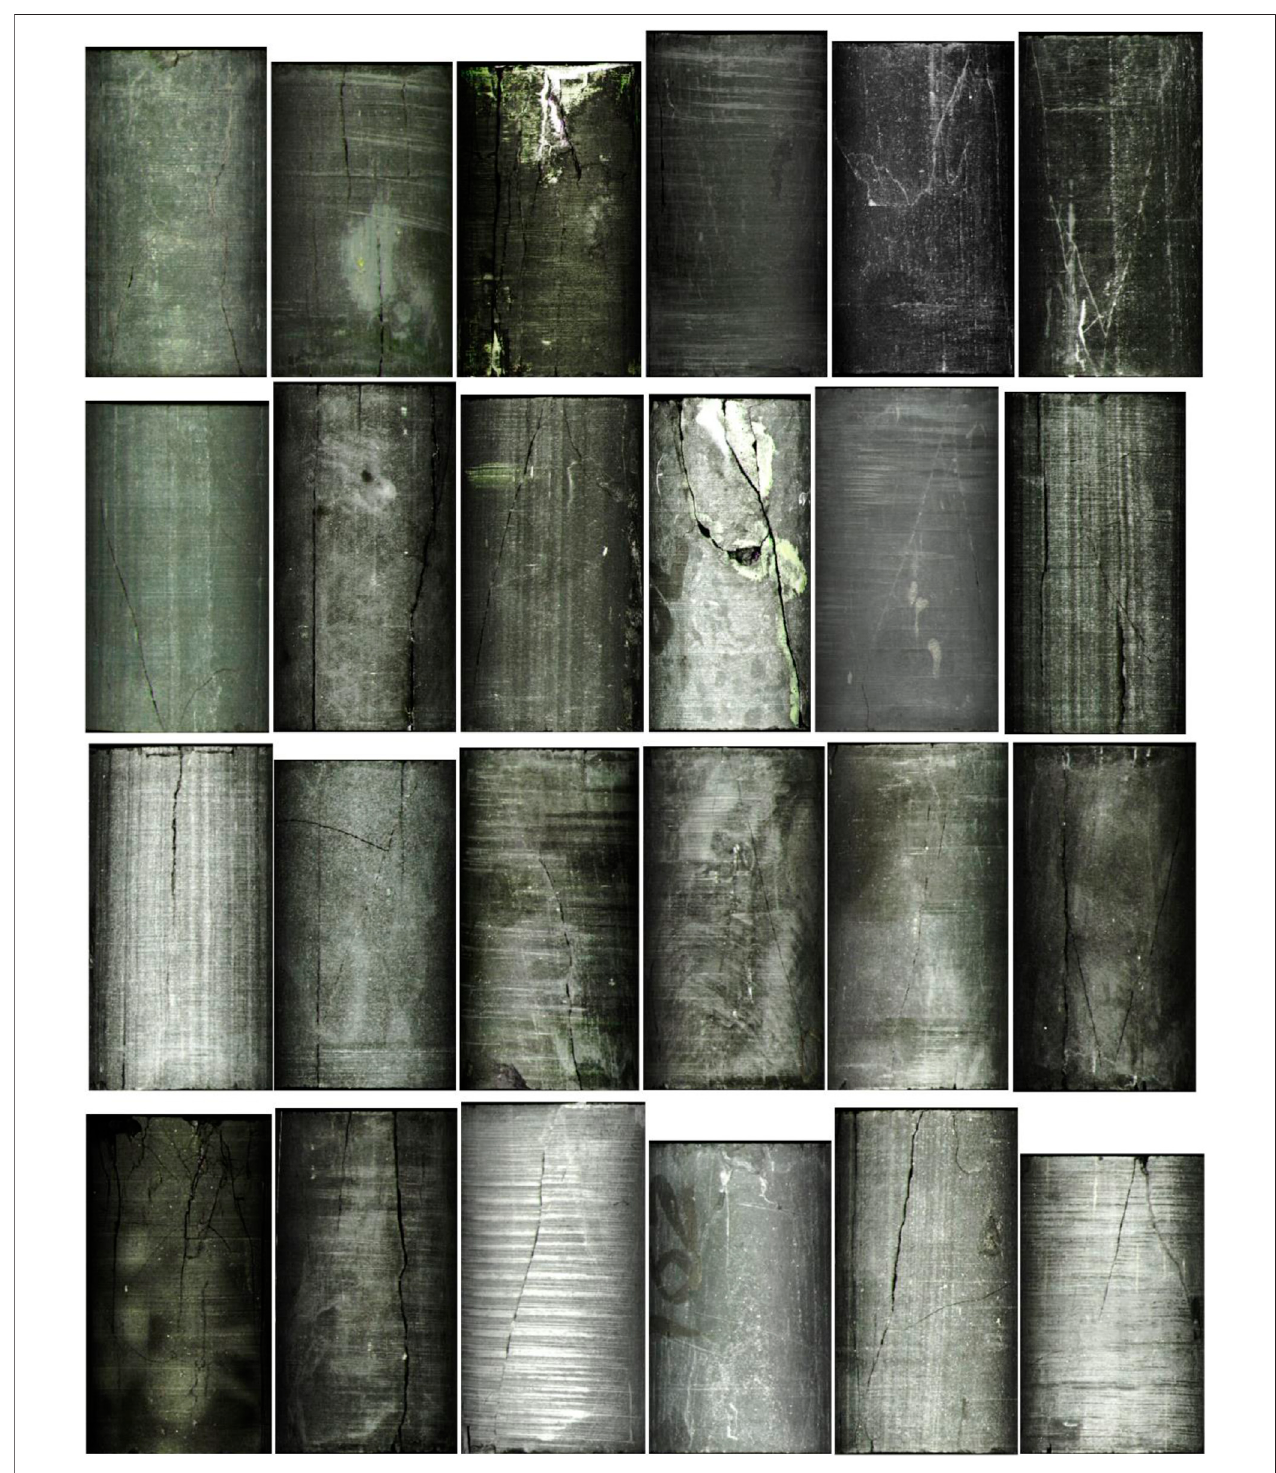
FIGURE 8 | Photos of 24 post-fractured core samples.